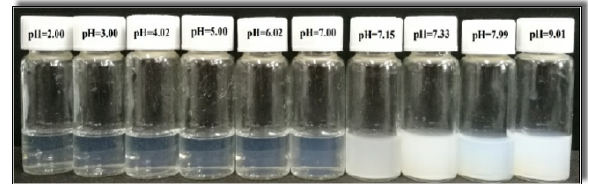
Figure 8. Phase behaviour of CTAB-MA solution at different pH